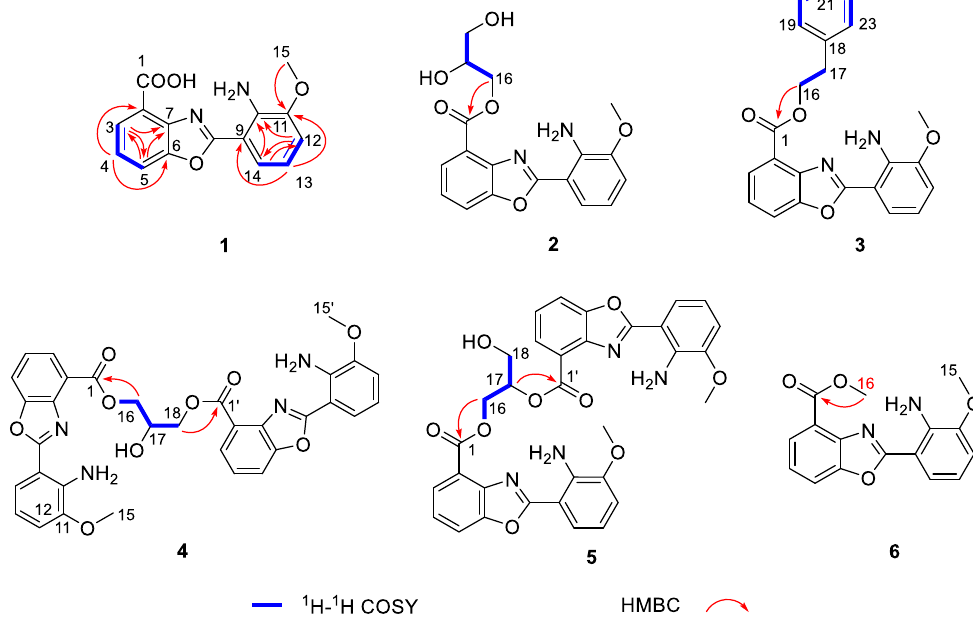
Figure 2. The Key 1 H - 1 H COSY and HMBC correlations compounds 1 ‒ 6.